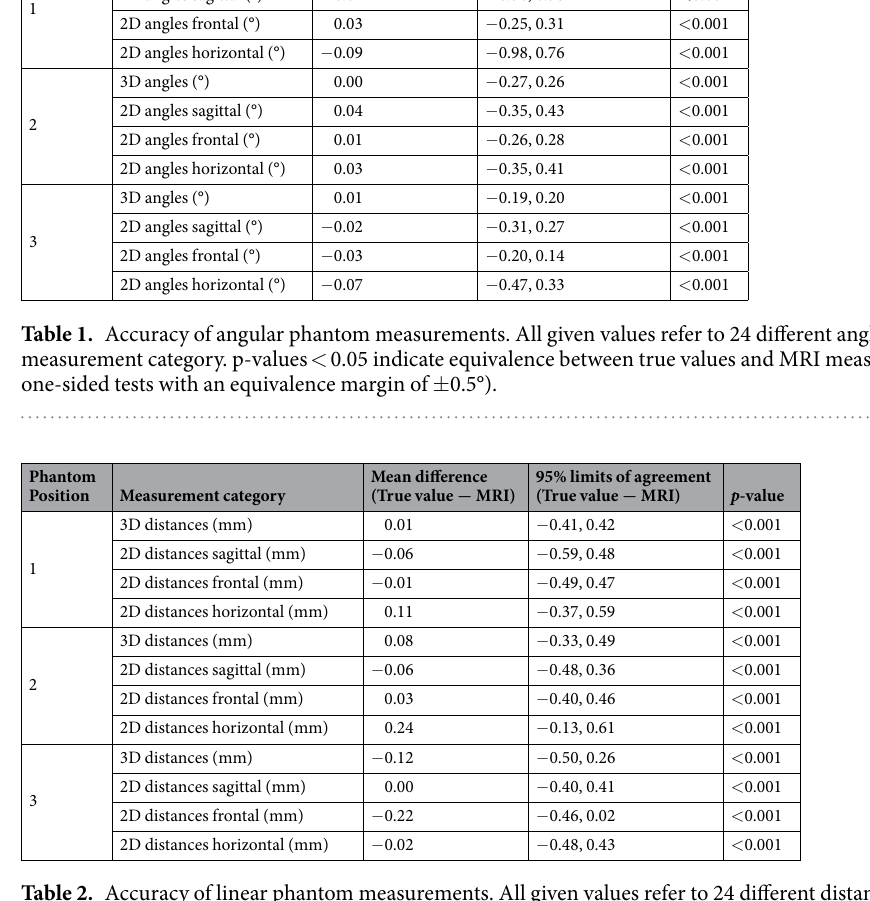
Table 2. Accuracy of linear phantom measurements. All given values refer to 24 different distances per measurement category. p-values < 0.05 indicate equivalence between true values and MRI measurements (two one-sided tests with an equivalence margin of ± 0.5